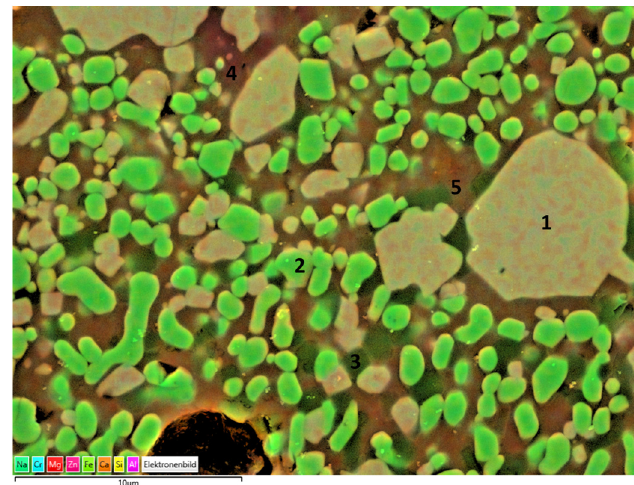
Figure 13. EDS mapping of slag 1 particles sintered at 1150 °C. Table 2. Corresponding phase components of slag 1 particles sintered at 1150 °C.